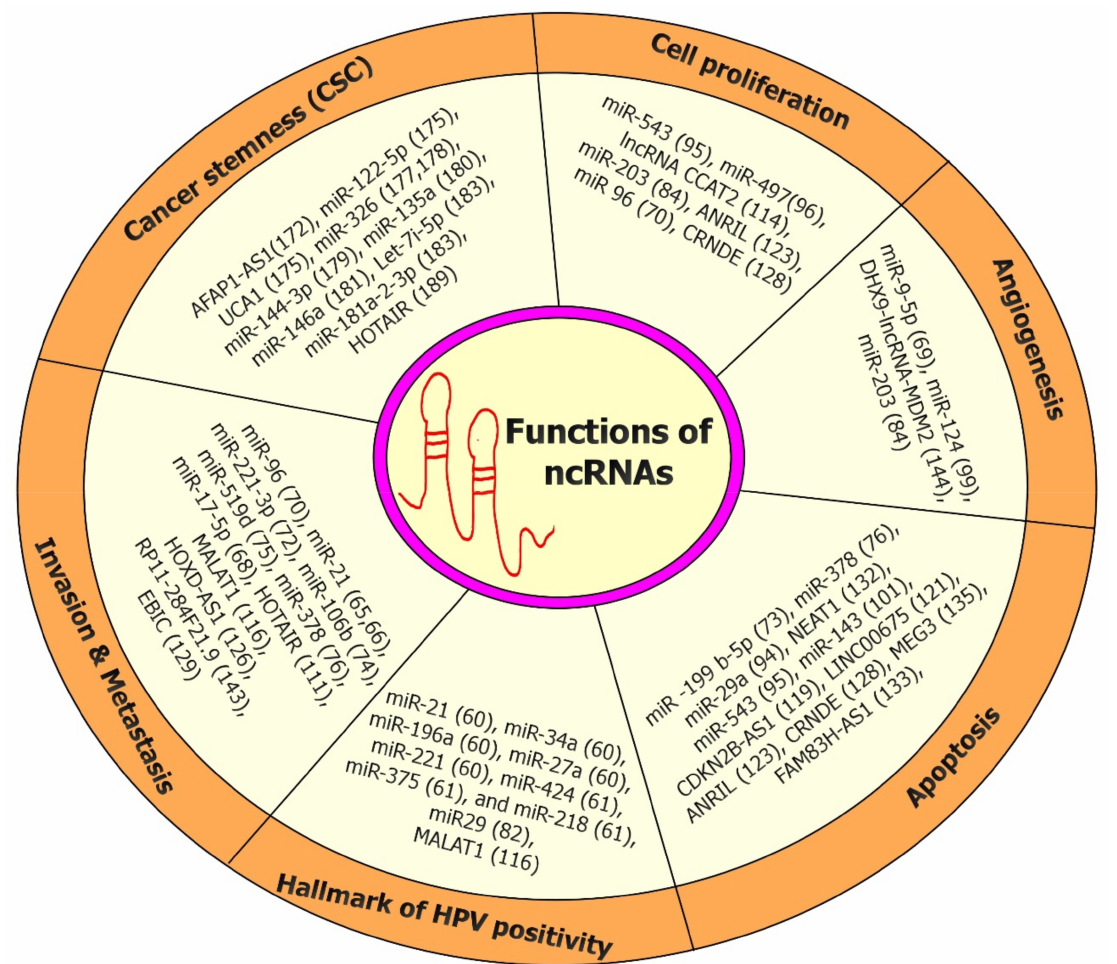
Figure 3. Different biological function of ncRNAs in CC. NcRNAs play a crucial role in the regulation of cell proliferation, cell cycle, cell migration and invasion, epithelial–mesenchymal transition (EMT), and angiogenesis in